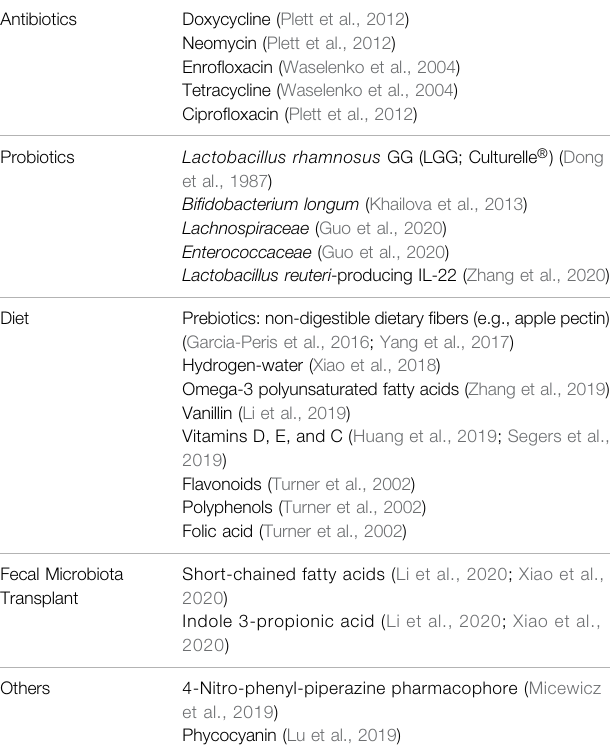
TABLE 2 | Targeted treatments that modulate the microbiome and radiation response.